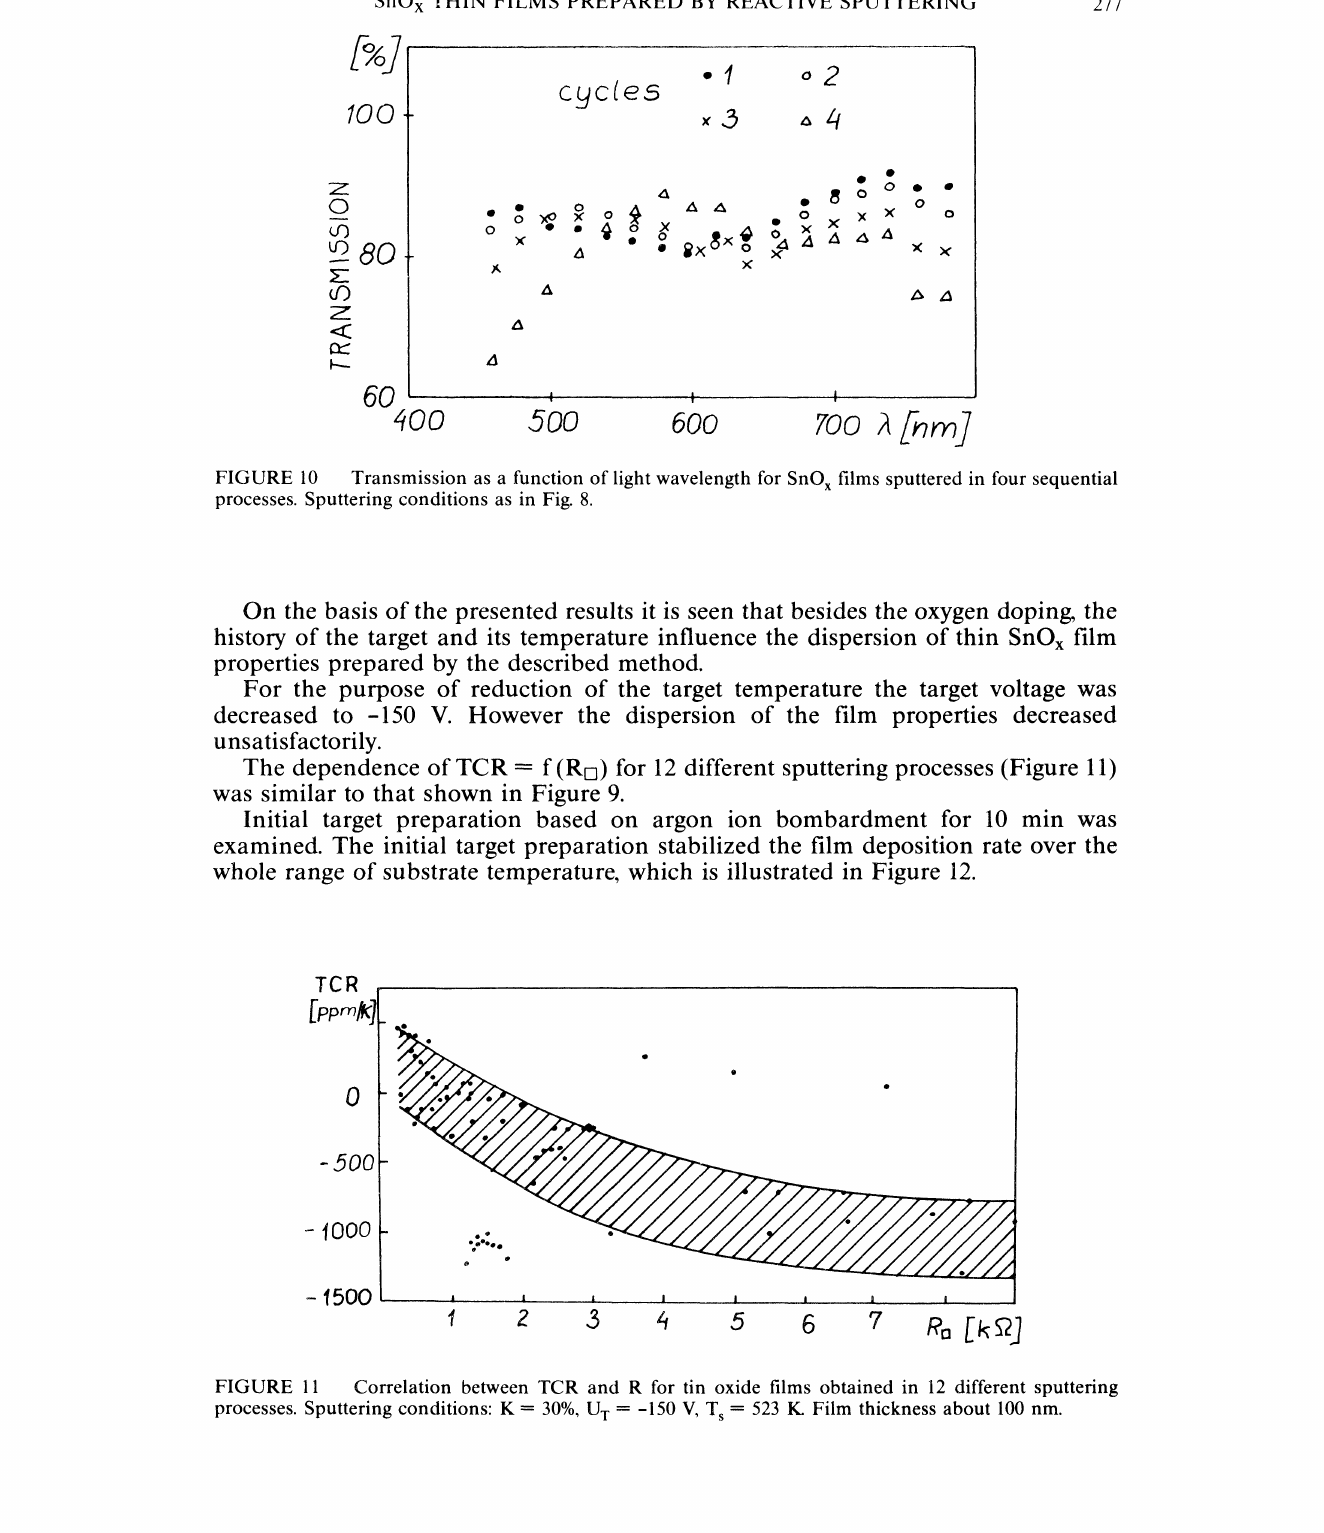
Correlation between TCR and R for tin oxide films obtained in 12 different sputtering processes. Sputtering conditions: K 30%, U T -150 V, T 523 K. Film thickness about 100